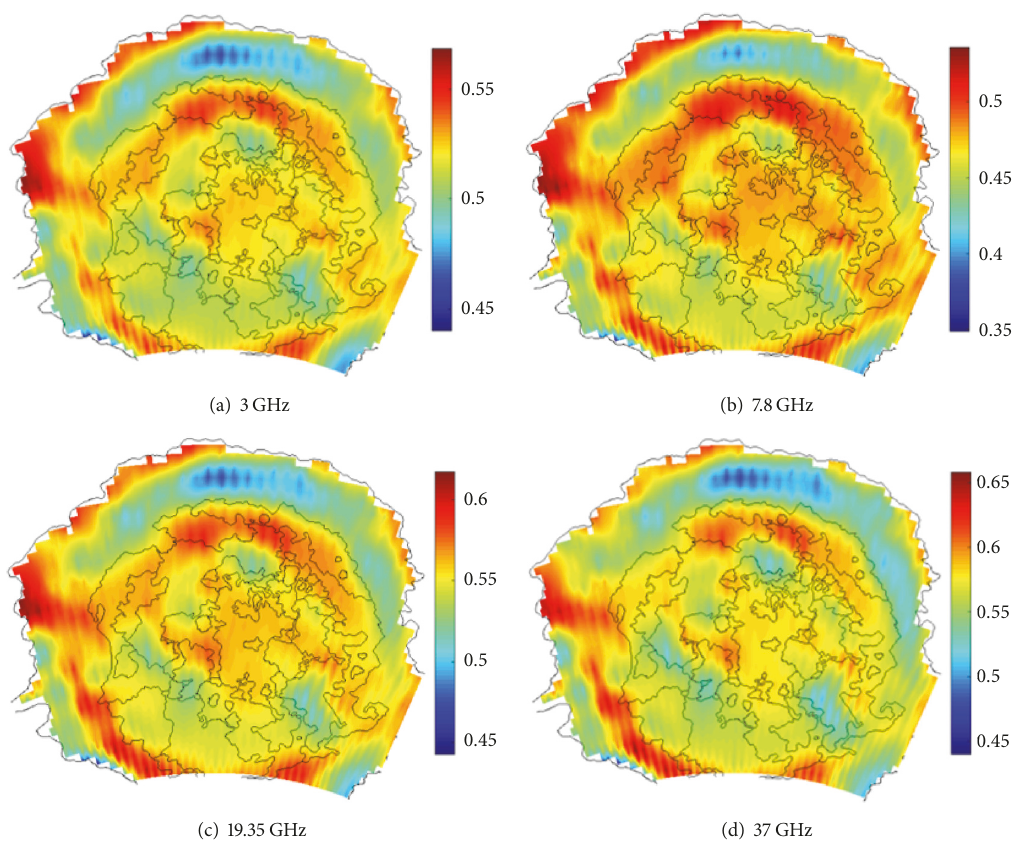
Figure 10: Emissivity maps of Schr¨odinger